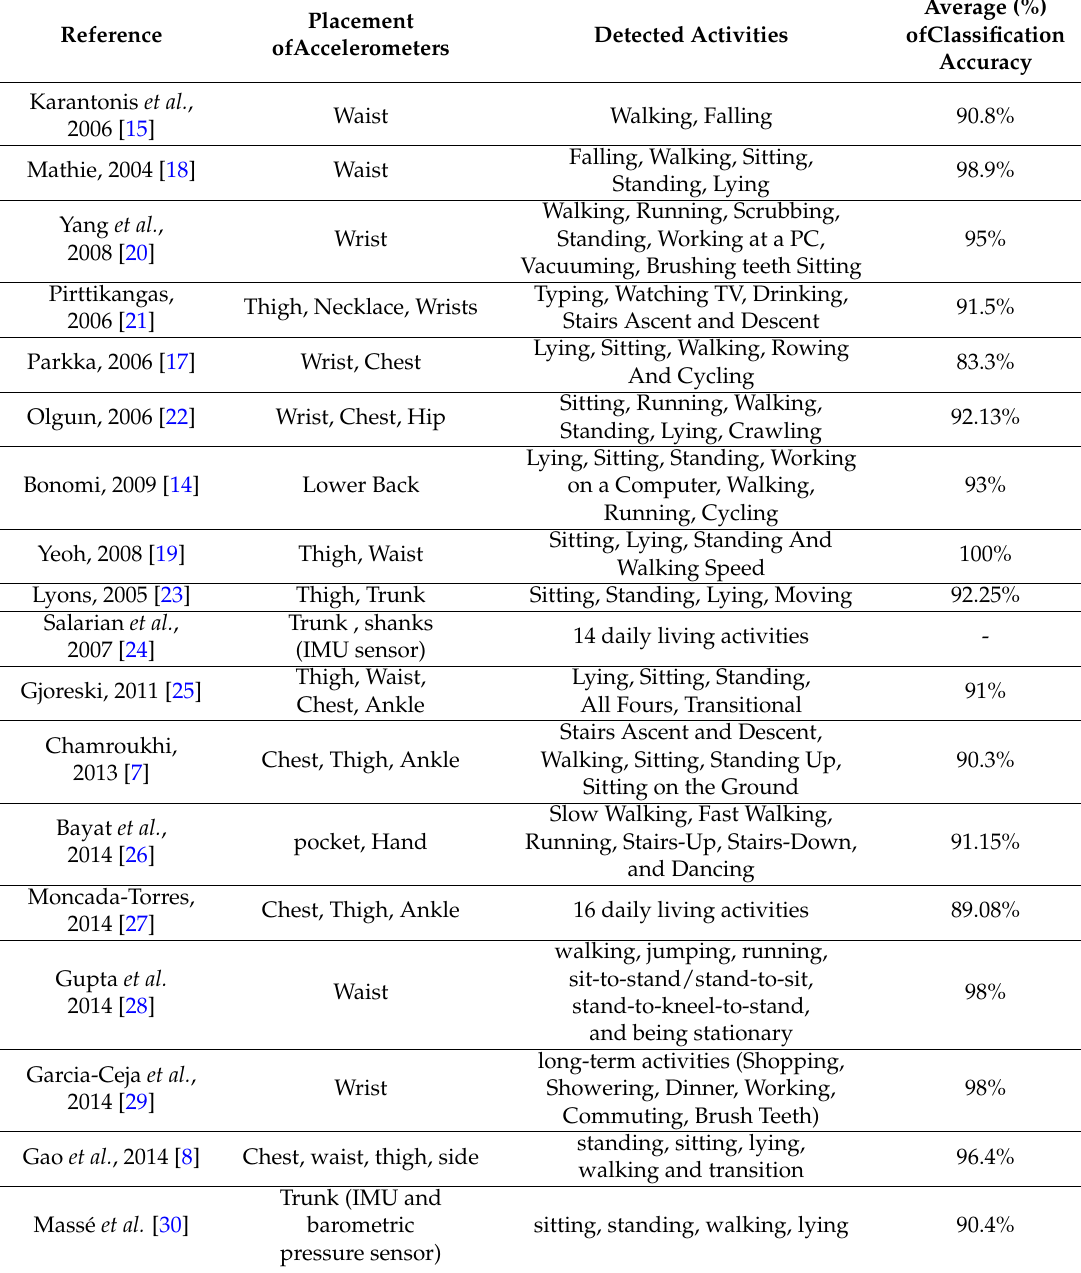
Table 1. Review of studies on accelerometer placement for human activity